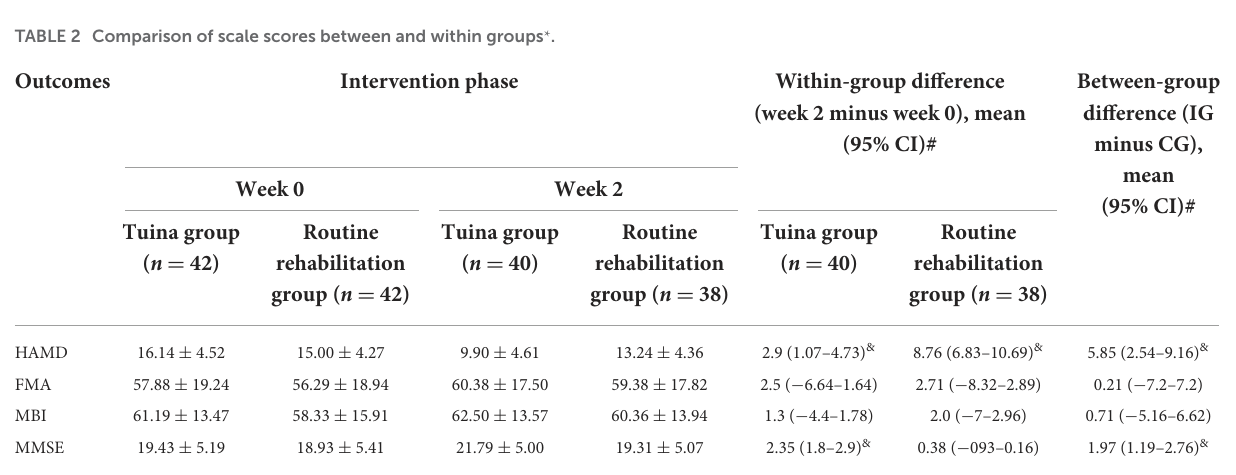
TABLE 2 Comparison of scale scores between and within groups *